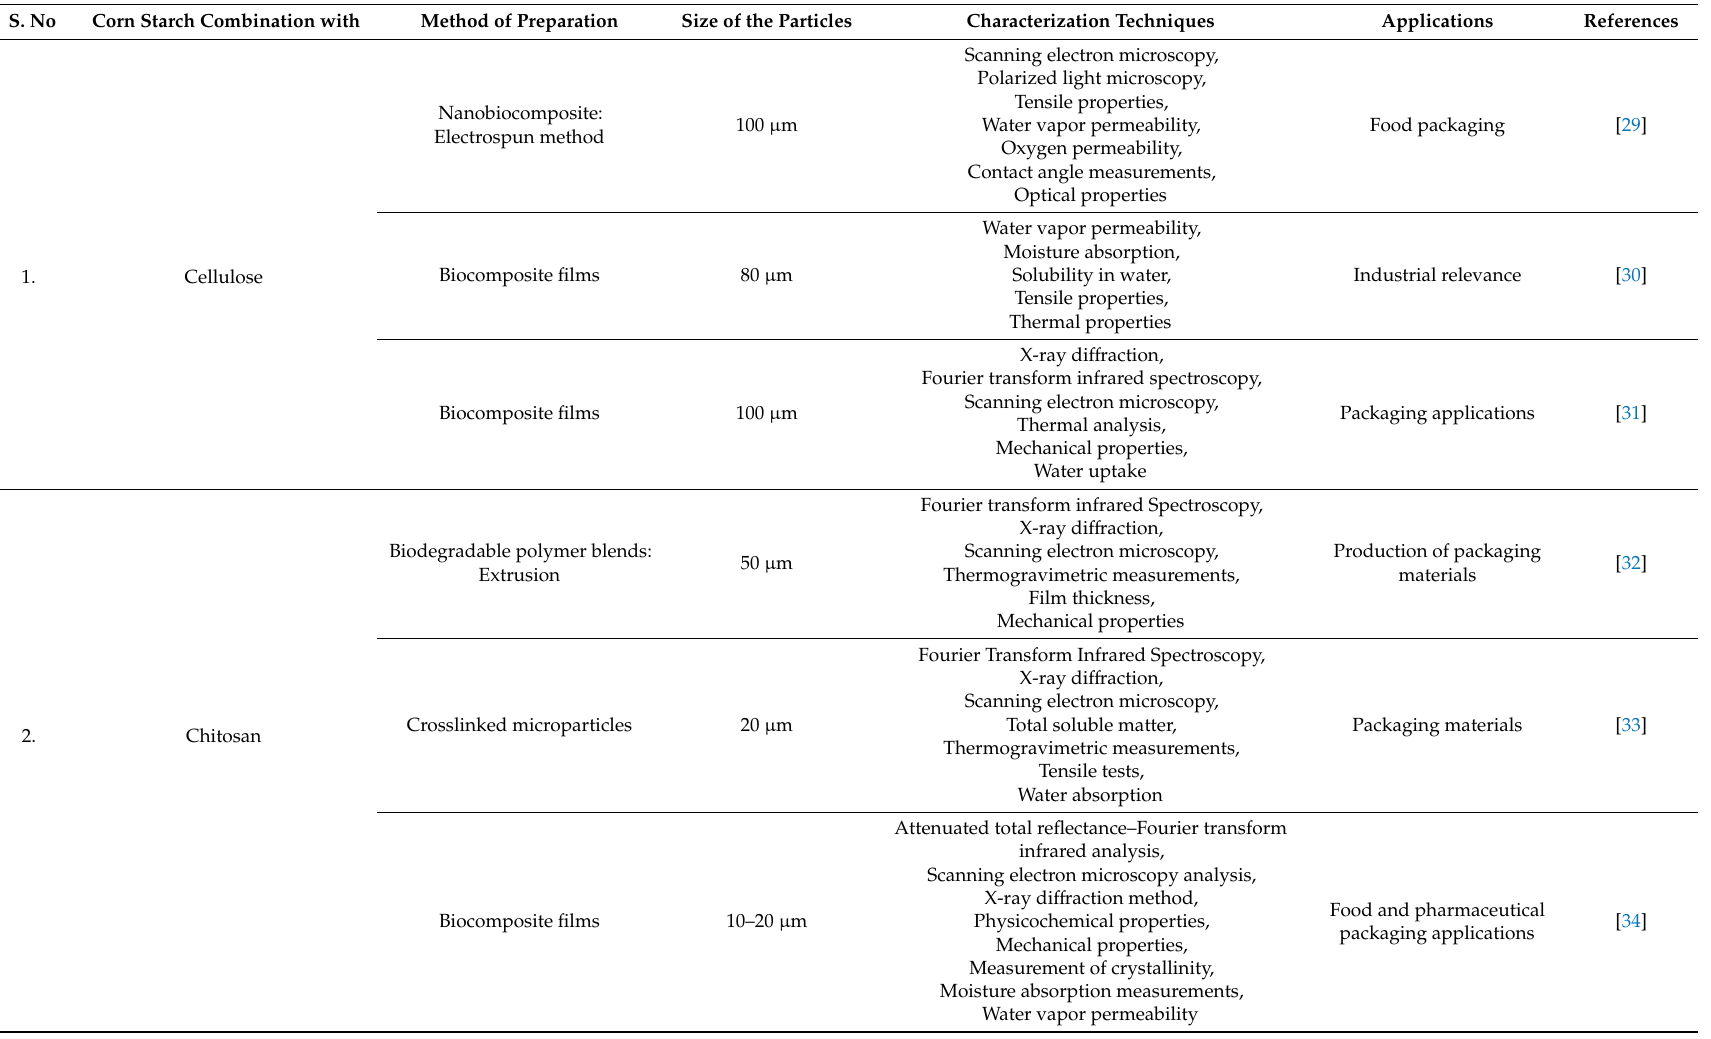
Table 1. Combination of corn starch with natural polymers, method of preparation, characterization techniques, and their applications. S.